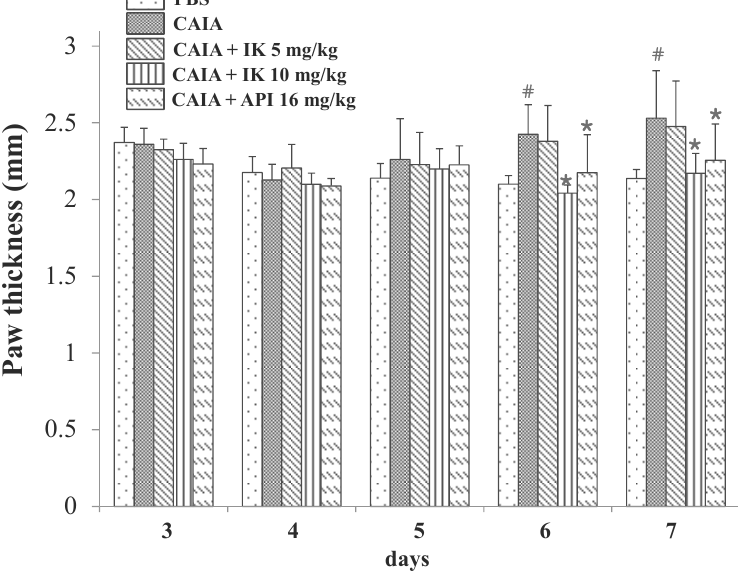
Figure 4. Effect of IK and API on paw thickness in CAIA mice. Paw thickness was measured using a digital caliper every day after LPS injection and oral administration of treatments. The average thickness of both hind legs was used. Data are presented as means ± SD ( n = 6). # p < 0.05 vs. PBS-group and * p < 0.05 vs. CAIA-group.